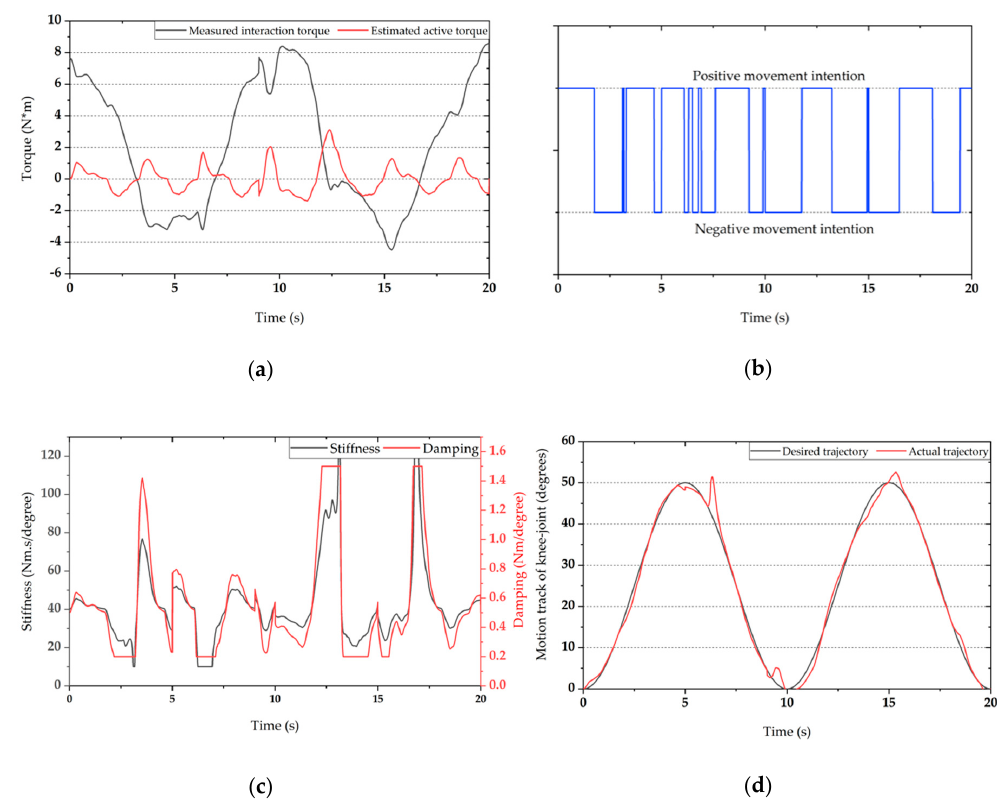
Figure 12. Experimental results of track tracking under variable admittance conditions. ( a ) Comparison between measured interaction torque and estimated active torque. ( b ) Movement intention of subject. ( c ) Change of admittance parameters. ( d ) Track tracking result under variable admittance condition. Table 6. Experimental results under the condition of variable admittance.